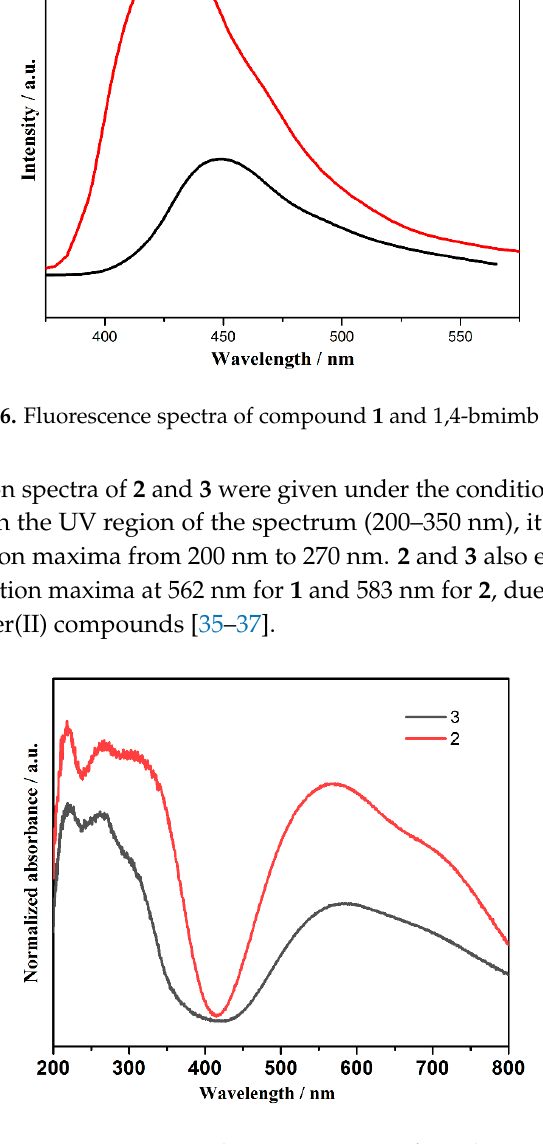
Table S1: Selected bond distances (Å) and angles ( ◦ ) for 1 , Table S2: Selected bond distances (Å) and angles ( ◦ ) for 2 , Table S3: Selected bond distances (Å) and angles ( ◦ ) for 3 , Table S4: Hydrogen bond distances (Å) and angles ( ◦ ) for 1 , Table S5: Hydrogen bond distances (Å) and angles ( ◦ ) for 2 , Table S6: Hydrogen bond distances (Å) and angles ( ◦ ) for 3 , Figure S1: The PXRD data of 1 , Figure S2: The PXRD data of 2 , Figure S3: The PXRD data of 3